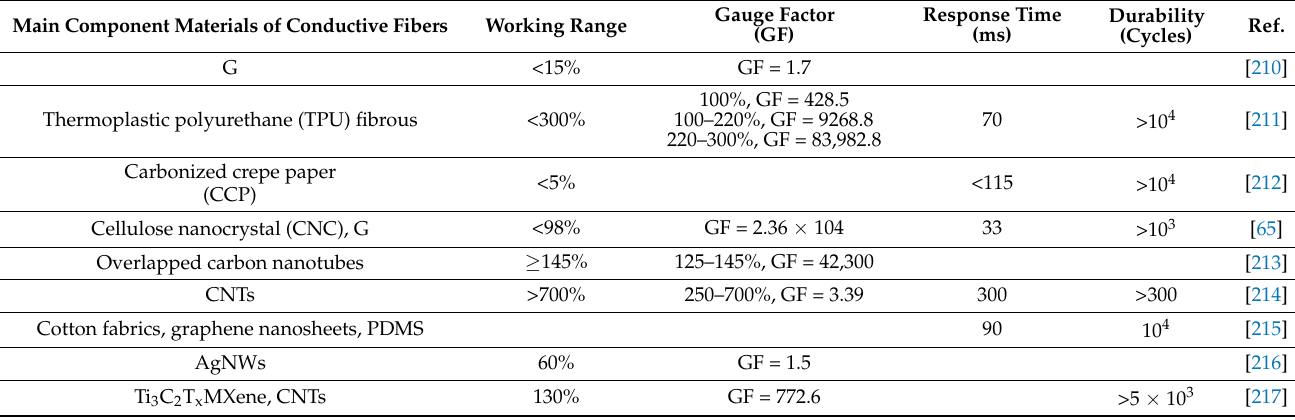
Figure 12. Schematic of preparation process of a flexible and anisotropic strain sensor. ( i – iii ) Schematic illustration showing the fabrication process of crepe cellulose paper with aligned cellulose fibers. ( iv ) Schematic illustration showing the fabrication process of the flexible CCP strain sensor [208]. Table 6. Performance data sheets for selected resistive strain sensors.